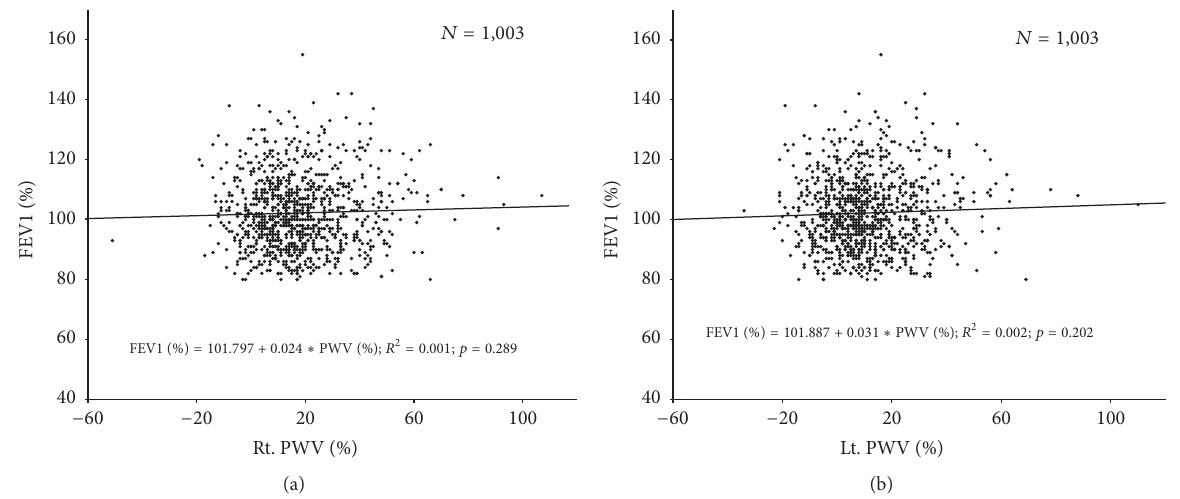
Figure 2: Simple linear regression analysis showing relationships of FEV1 (%) with Rt. PWV (%) (a) and Lt. PWV (%) (b).